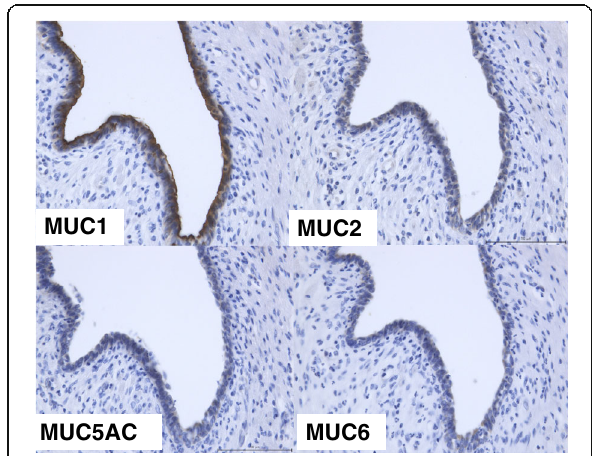
Fig. 7 Immunohistochemistry, this tumor is MUC1(+), MUC2( −